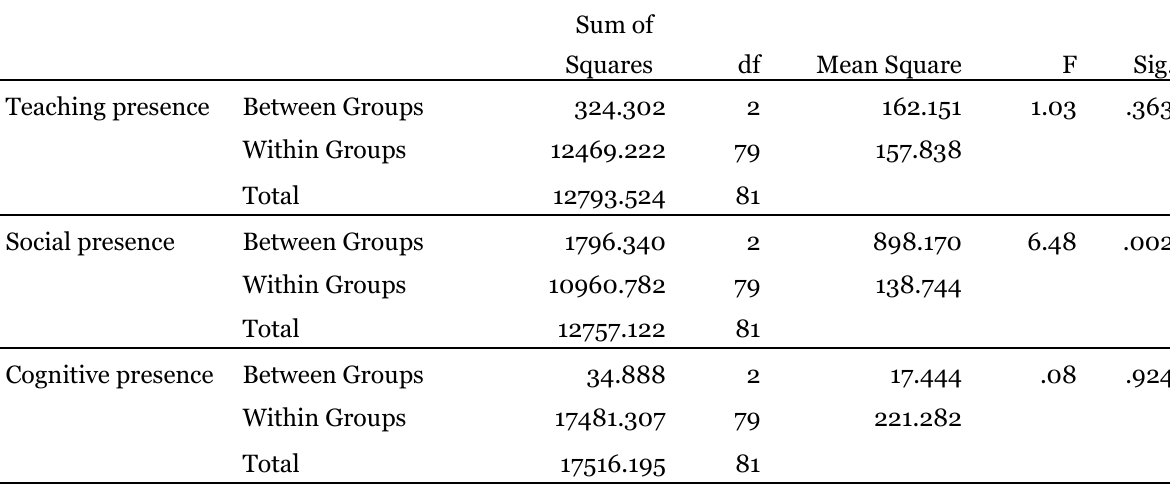
Sum of Squares df Mean Square F